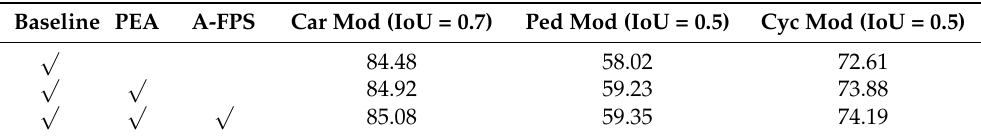
Table 3. Performance of proposed method with different configurations on KITTI val set. The results are evaluated with the average precision calculated based on 40 recall positions.